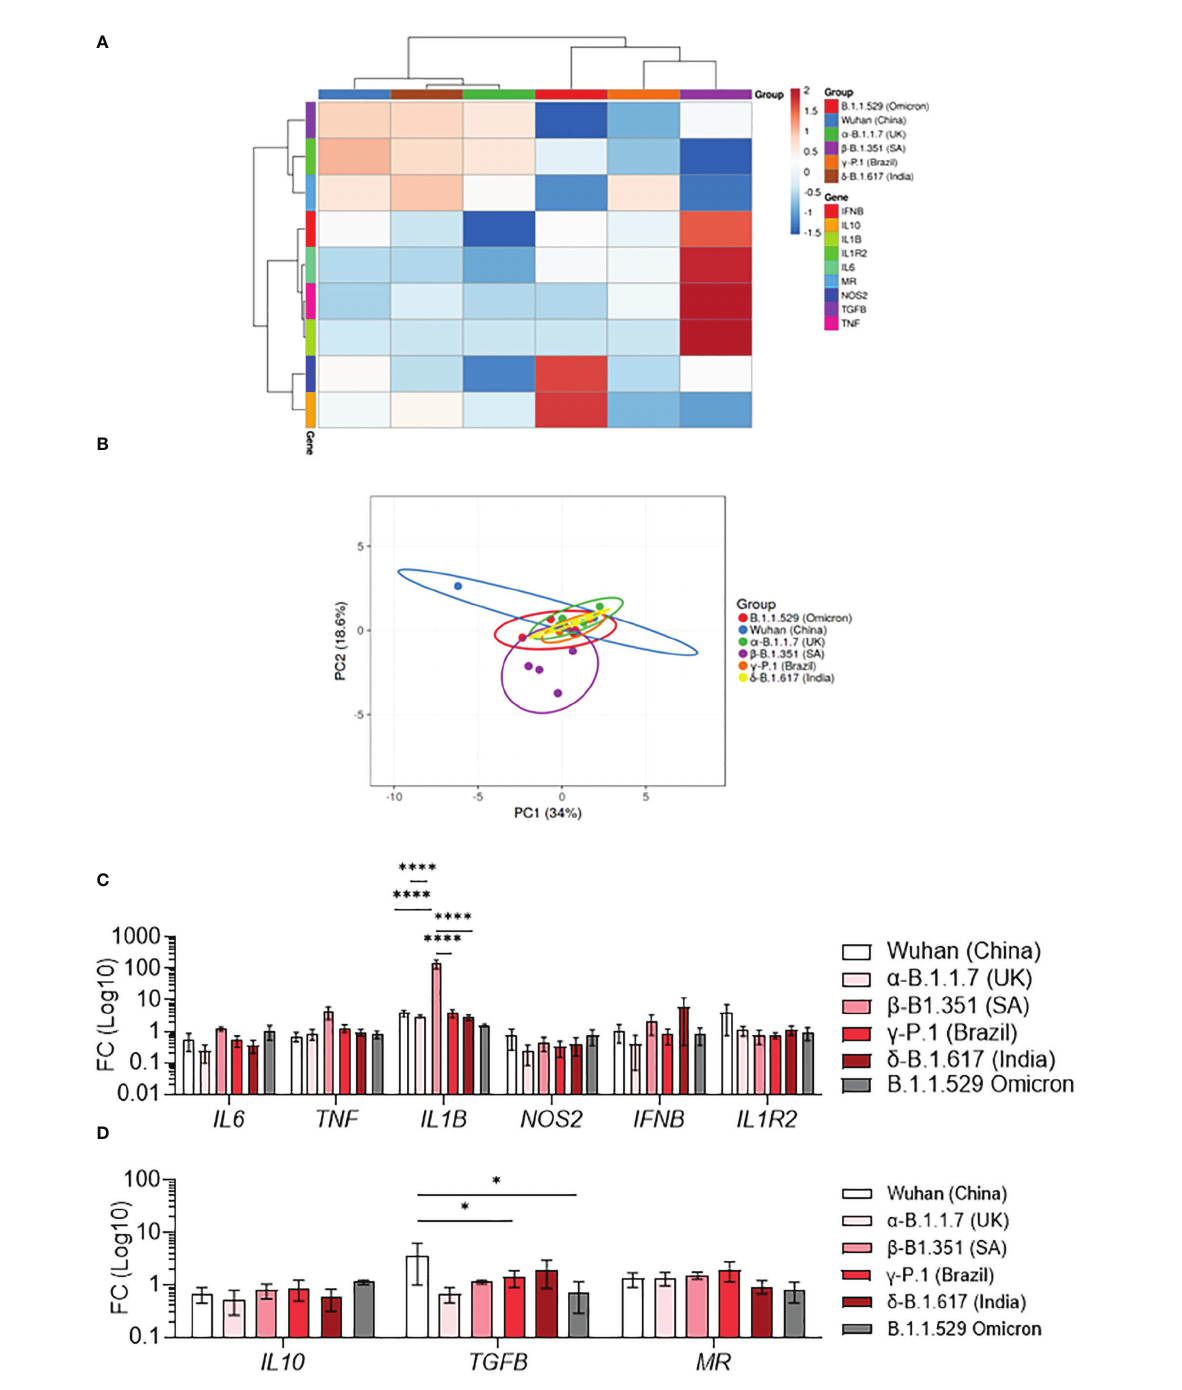
FIGURE 2 Polarization pro fi le of MDM infected with SARS-CoV-2 variants. MDMs were infected with SARS-CoV-2 variants including Wuhan (China), a - B.1.1.7 (United Kingdom, UK), b -B.1.351 (South Africa, SA), g -P.1 (Brazil), d -B.1.617 (India) and B.1.1.529 (Omicron) (0.1 MOI). (A – D) The polarization status was investigated by measuring the expression of M1 genes ( IL6 , TNF , IL1B , NOS2 , IFNB, IL1R2 ) and M2 genes ( IL10 , TGFB , MR ) at 6 hours post-infection. Data are illustrated as (A) hierarchical clustering and (B) principal component analysis obtained using ClustVis webtool. (C, D) Fold change (FC) of (C) M1 genes and (D) M2 genes (Log 10). Data values represent the mean ± SEM from 4 healthy donors whose experiments were carried out in triplicate. Statistical analysis was performed with one-way ANOVA and Tukey ’ s multiple comparison test. * p ≤ 0.05 and **** p ≤ 0.0001